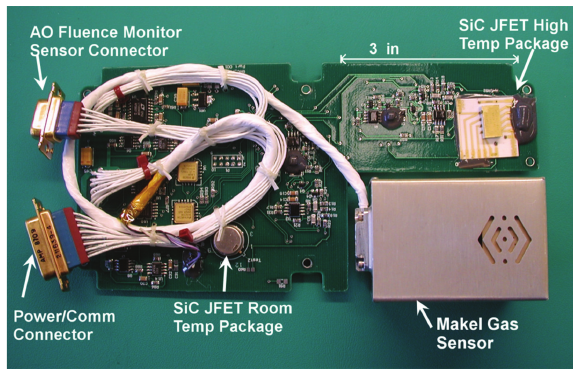
Figure 7: Silicon carbide junction field effect transistor (SiC JFET) health monitoring flight experiment circuit board (image courtesy of NASA).